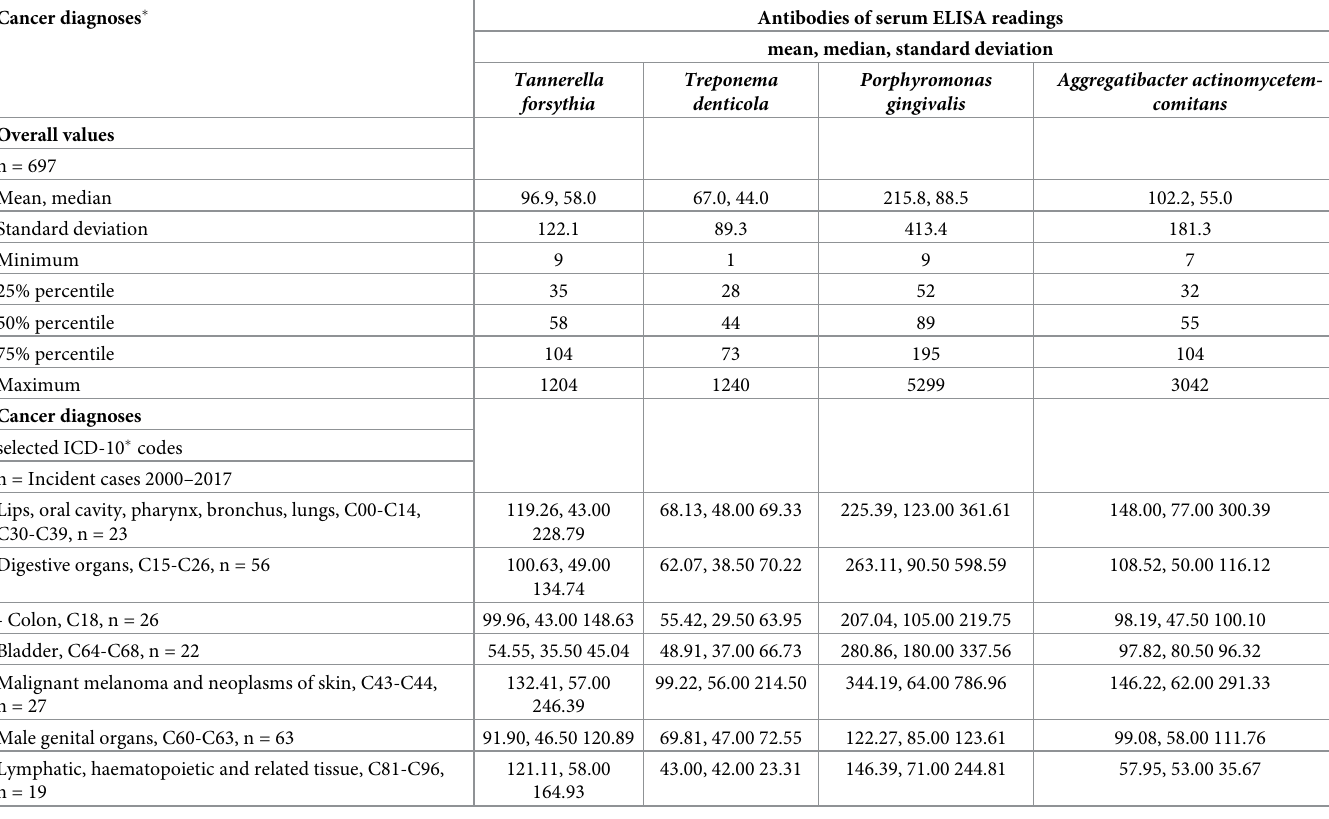
Table 2. Descriptives of the ELISA readings of the antibodies to the bacteria Tannerella forsythia , Treponema denticola , and Porphyromonas gingivalis , collectively termed the red complex, and Aggregatibacter actinomycetemcomitans : The Oslo II-study health screening in